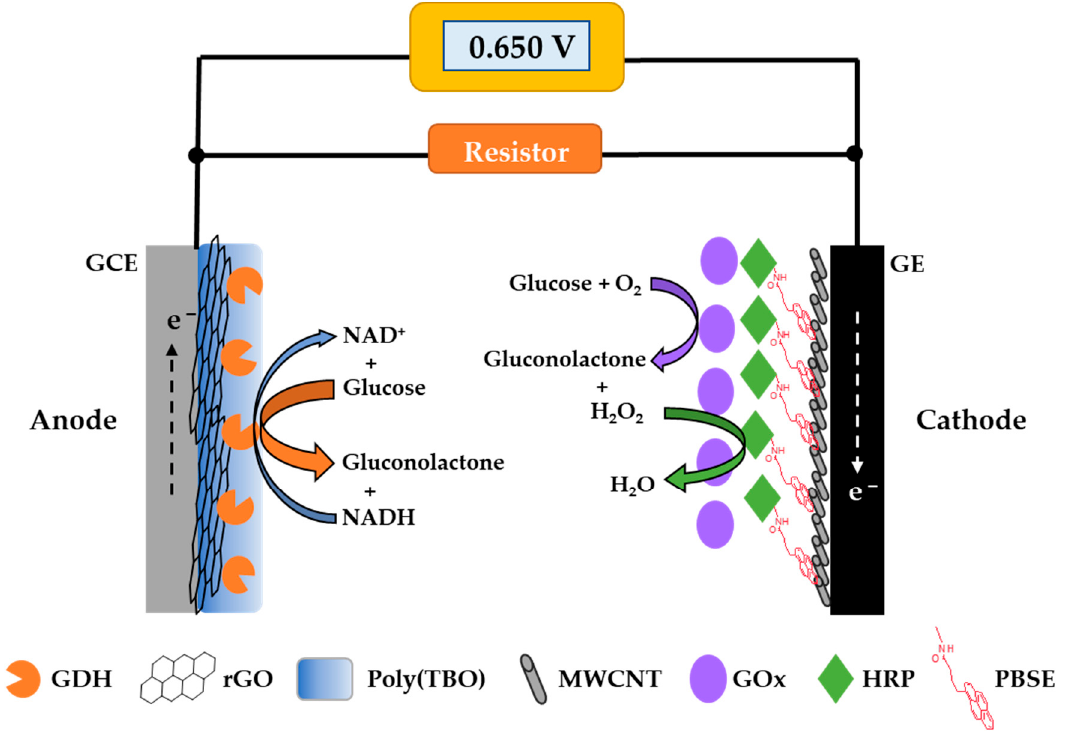
Figure 1. Scheme of the glucose self-powered biosensor developed in this work based on an enzymatic biofuel cell. GDH: glucose dehydrogenase, rGO: reduced graphene oxide, Poly(TBO): poly(toluidine-blue O), MWCNT: multi-wall carbon nanotube, GOx: glucose oxidase, HRP: horseradish peroxidase, PBSE: 1-pyrenebutyric acid N -hydroxysuccinimide ester, GCE: glassy carbon electrode, GE: graphite electrode.